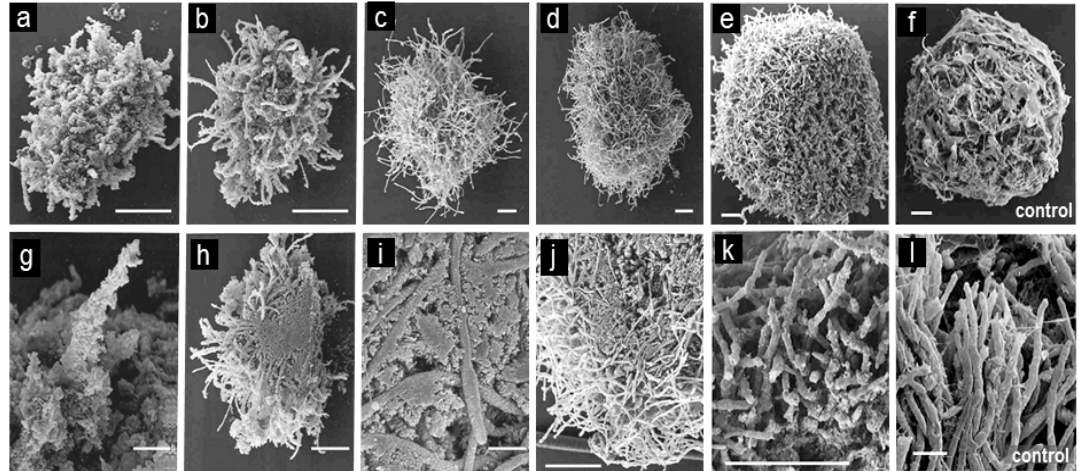
Figure 3. Scanning electron micrographs (SEM) showing the morphology of Cladosporium cladosporioides 396 pellets grown in submerged culture in a medium containing 0.5% (w/v) bentonite which were cultivated for different time periods after spore inoculation: ( a,g ) 17 h; ( b,h ) 24 h; ( c,i ) 38 h, ( d,j ) 45 h and ( e,k ) 140 h. It is also shown the morphology of 140 h-old pellets grown in the clay-free control medium ( f,l ). SEM images present the whole pellets ( a – f ) and internal structure of fractured pellets ( g – l ). Scale bars = 100 µm ( a – f , h , j , k ), 10 µm ( g , i , l ) (adapted from [175]).